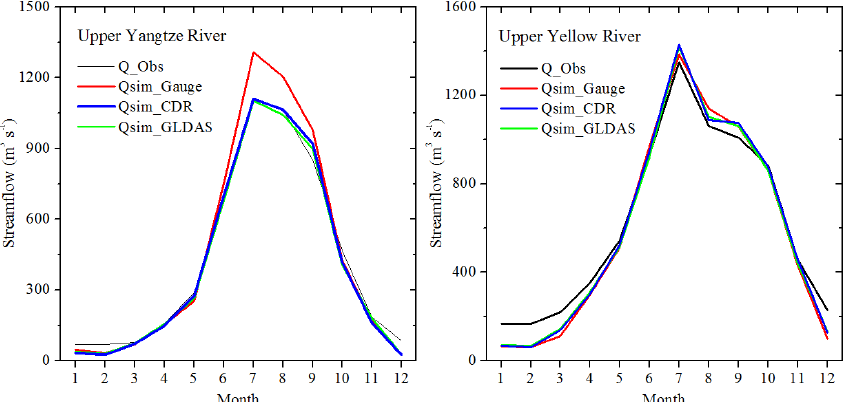
Figure 6. The comparison between the observed streamflow (black) and the simulated streamflow using ground-based precipitation (red), GLDAS precipitation (green), and PERSIANN-CDR precipitation (blue) in the upper Yangtze River basin and upper Yellow River